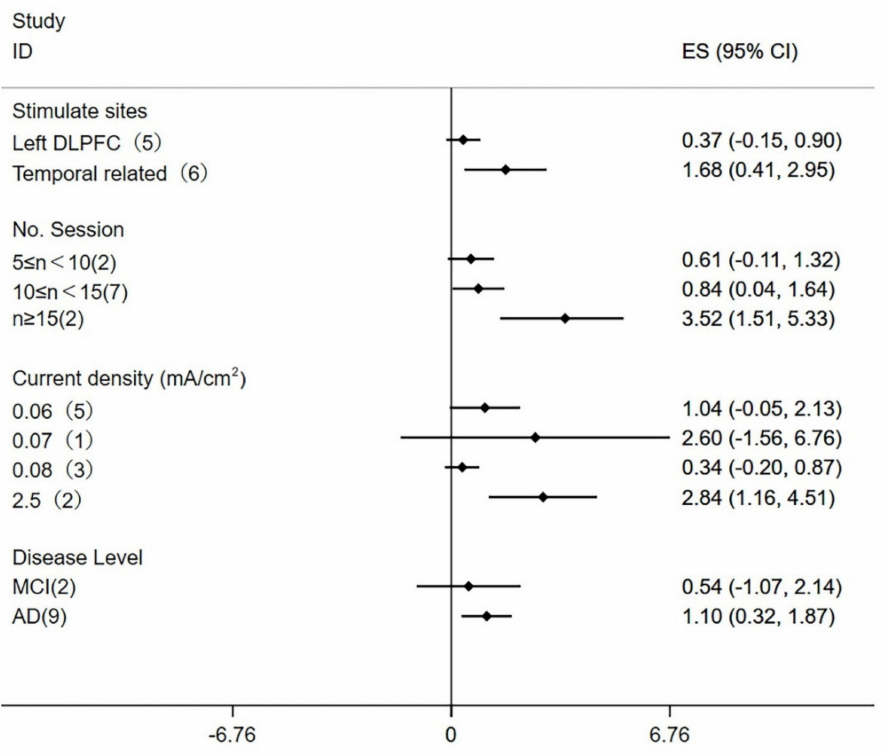
Figure 3. Subgroup analyses of